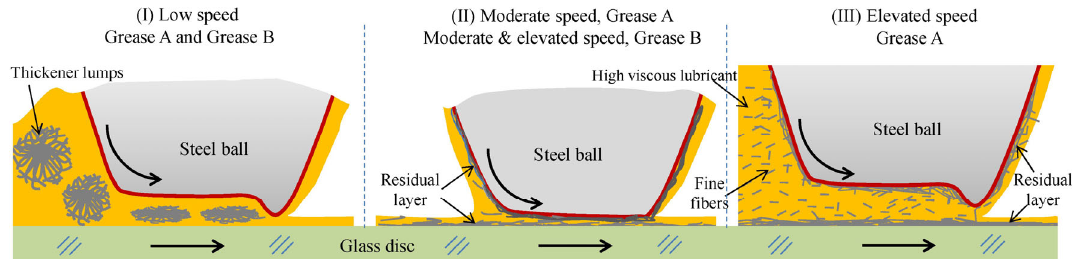
Fig. 5 Schematic of lubrication states over different speed ranges for grease A and B [49]. Reproduced with permission from Ref. [49]. © The author(s),